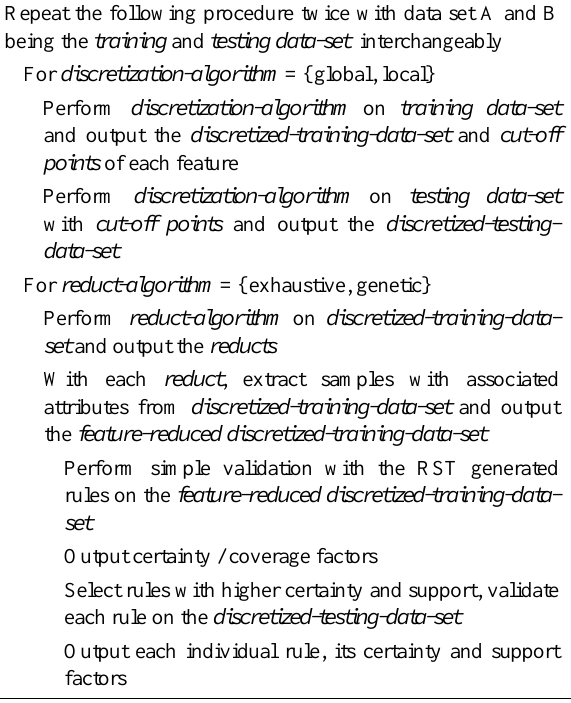
Table 2. Procedure of Experiment